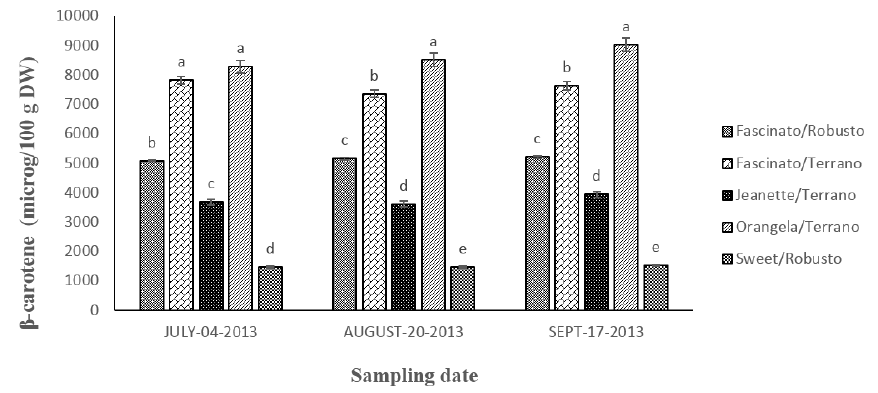
Figure 7. Content in β-carotenes in grafted bell pepper harvested on three different sampling dates. a–e Different letters indicate statistical difference ( p ≤